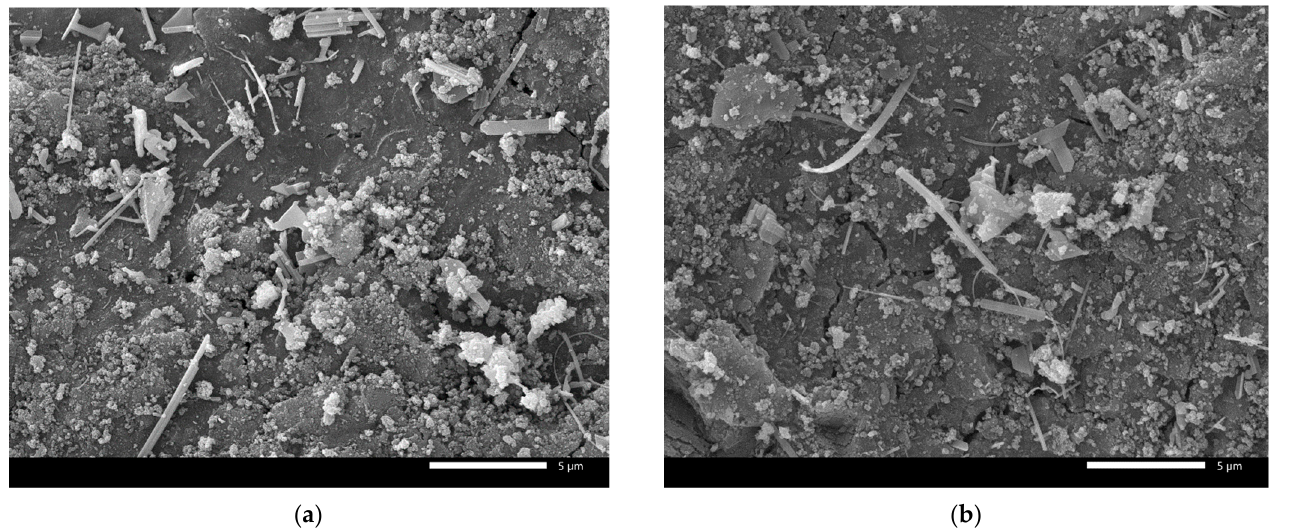
Figure 20. ( a ) Photo of the spent catalyst after deactivation type 1 (scanning electron microscopy (SEM)). ( b ) Photo of the spent catalyst after deactivation type 2 (SEM).